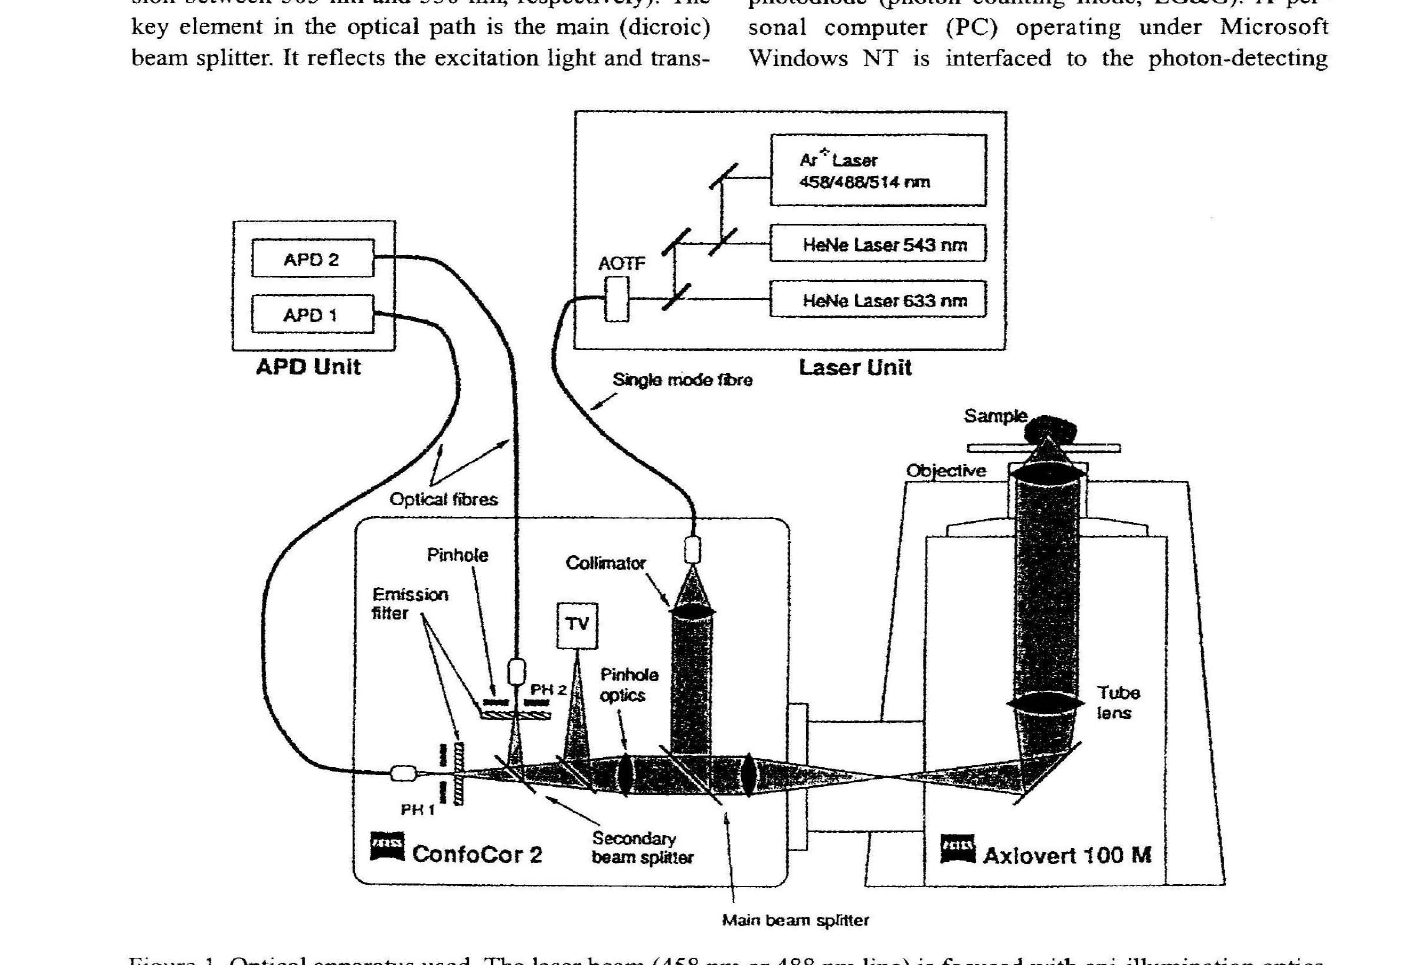
Figure 1. Optical apparatus used. The laser beam (458 run or 488 nrn line) is focused with epi-illumination optics to a small spot in the sample solution. The main (dichroic) beam splitter reflects the excitation light towards the objective and transmits the fluorescencen light originating from the sample. Fluorescence light collected by the objective passes through the main (dichroic) beam splitter. The light filtered by emission filters (see Materials and Methods, Optical setup) is directed to a pinhole that blocks scattered excitation light and fluorescence light from outside the focal spot. Fluctuations in the filtered light are measured by a photodiode PteridinesiVol. 121No.